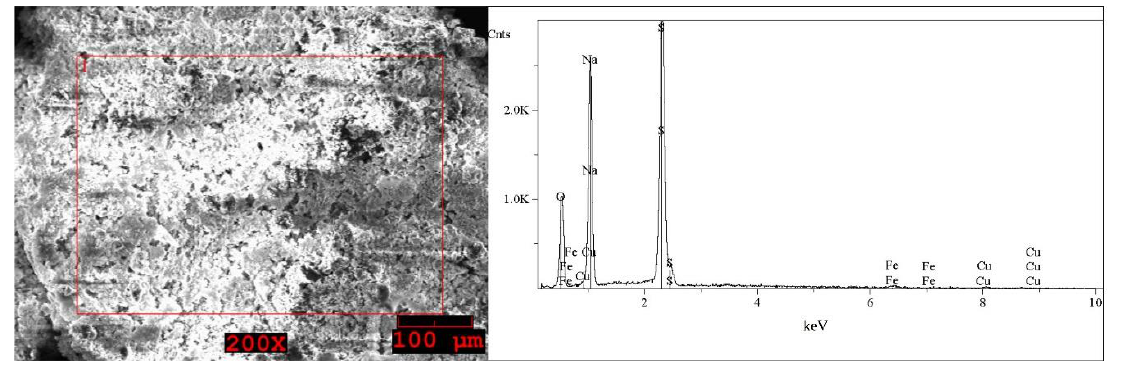
Figure 7. SEM image of the brown solid phase sample precipitated out from the post-leaching solution II (first step) and EDS spectrum taken from the area marked in the image.